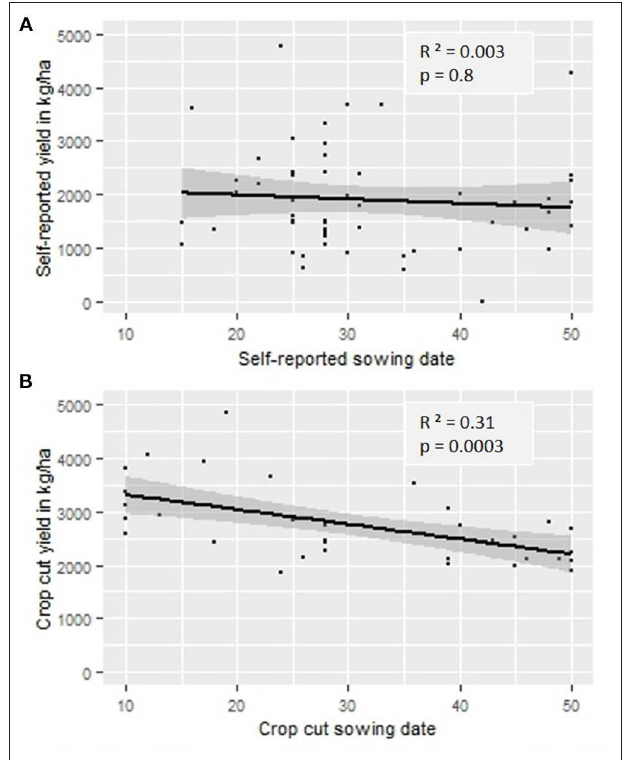
FIGURE 3 | Relationship between sowing date and self-reported yield (A) and crop cut yield (B) . R 2 and p values from linear regressions are also reported. The gray band around each regression line represents the standard error.